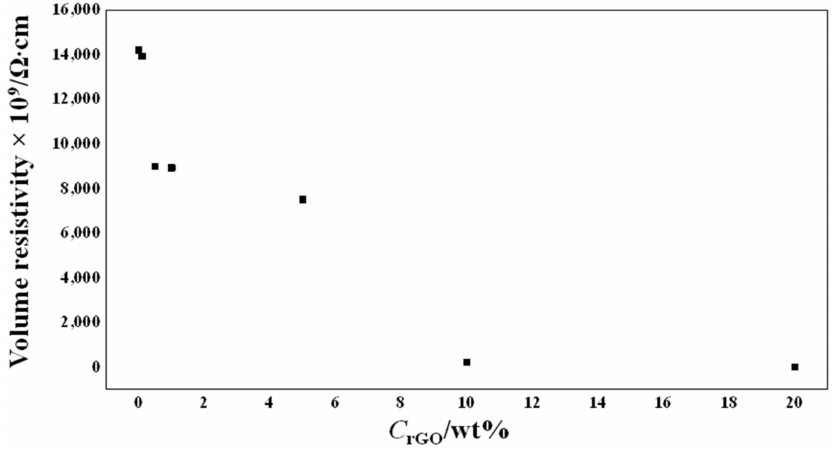
Figure 9. Electrical resistivity of the scaffolds as a function of the rGO content. A double logarithmic plot of the conductivity as a function of the filler volume fraction is shown in Figure 10. The experimental data can be linearly interpolated by two different straight lines, thus indicating the presence of two regimes below and above a critical filler concentration. The percolation threshold corresponds to the point where the two straight lines cross each other and was found to be 3.9 vol%, corresponding to a 5.7 wt% rGO concentration.